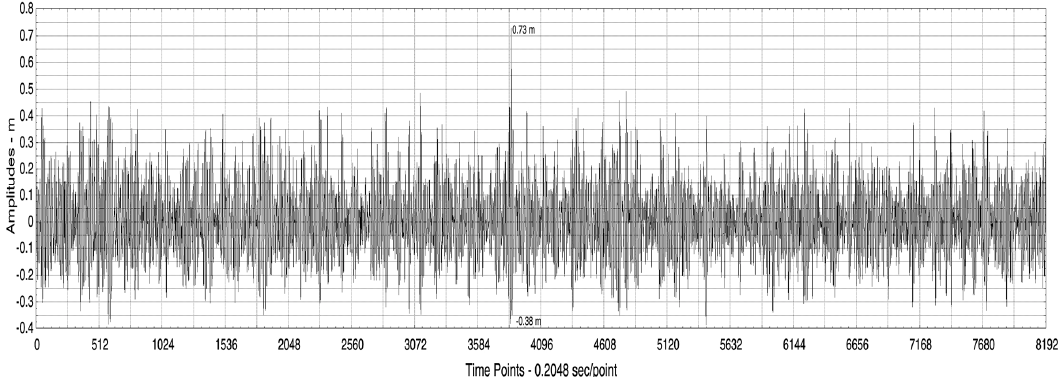
Figure 28. Time series of the Currituck Sound data after the removal of the low frequency part of the spectrum. This series is consistent with the known physics of the 1+1 NLS equation. The standard deviation of the filtered time series is 13.45 cm and significant wave height is 53.8 cm. The largest wave height is 111 cm, corresponding to 2.06 H s . J. Mar. Sci. Eng. 2020 , 8 , x FOR PEER REVIEW